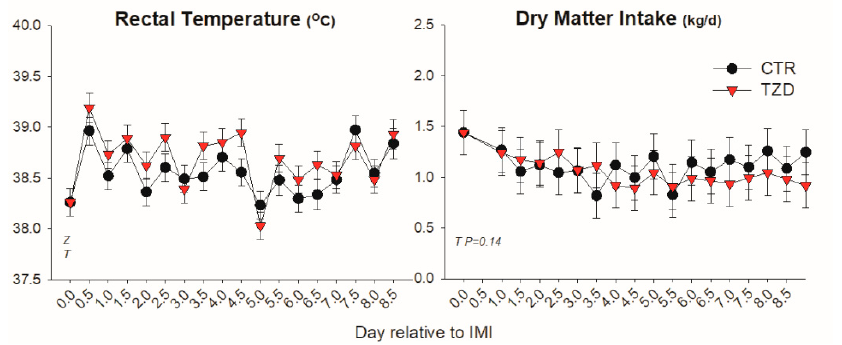
(TZD) or saline (CTR) after intramammary infusion of Strep. Uberis . Letters in the graph